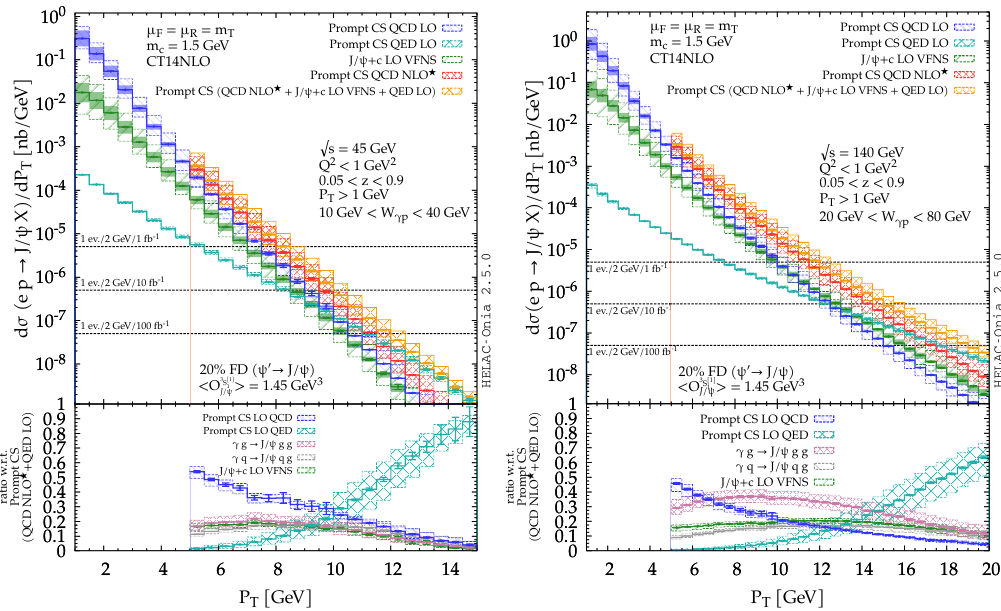
= 45 GeV (left) and (cid:112) s = 140 GeV ep ep , µ and PDFs as Fig. 1 F R